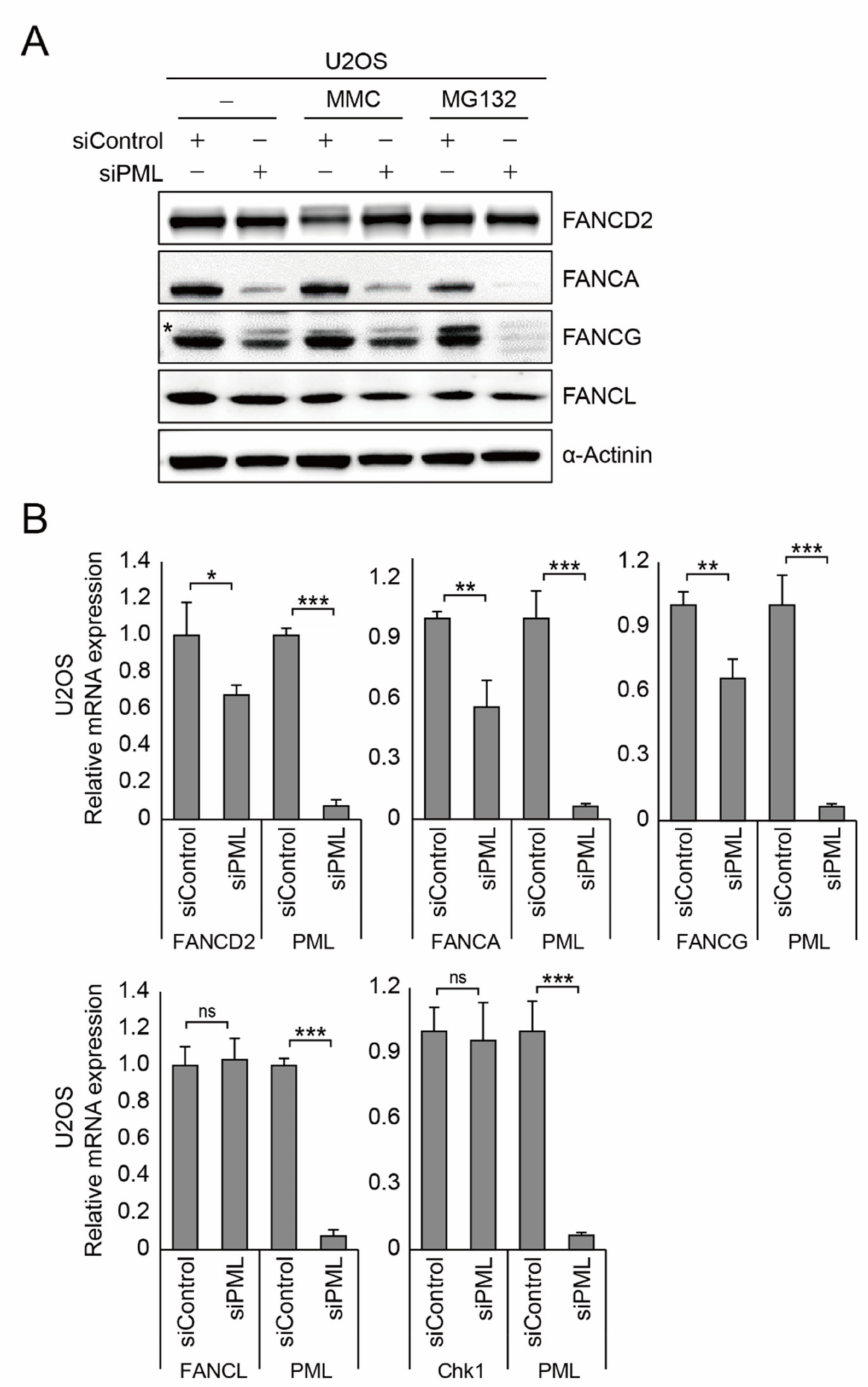
Figure 3. PML NBs control gene expression of Fanconi anemia core complex. ( A ) After depletion of PML , U2OS cells were treated with 1 µ M MMC or 10 µ M MG132 for 24 h. Expression of FANCD2 and FA core proteins including FANCA , FANCG , and FANCL was analyzed by immunoblotting assay. The asterisk indicates a cross-reactive artifact. ( B ) Relative mRNA expression of FANCD2 , FANCA , FANCG , FANCL , Chk1 , and PML was determined by real-time quantitative PCR in the U2OS cells depleted with PML . Data represent the mean ± SD from three independent experiments (*** p < 0.001; ** p < 0.01; * p < 0.05; ns, not significant ( p >